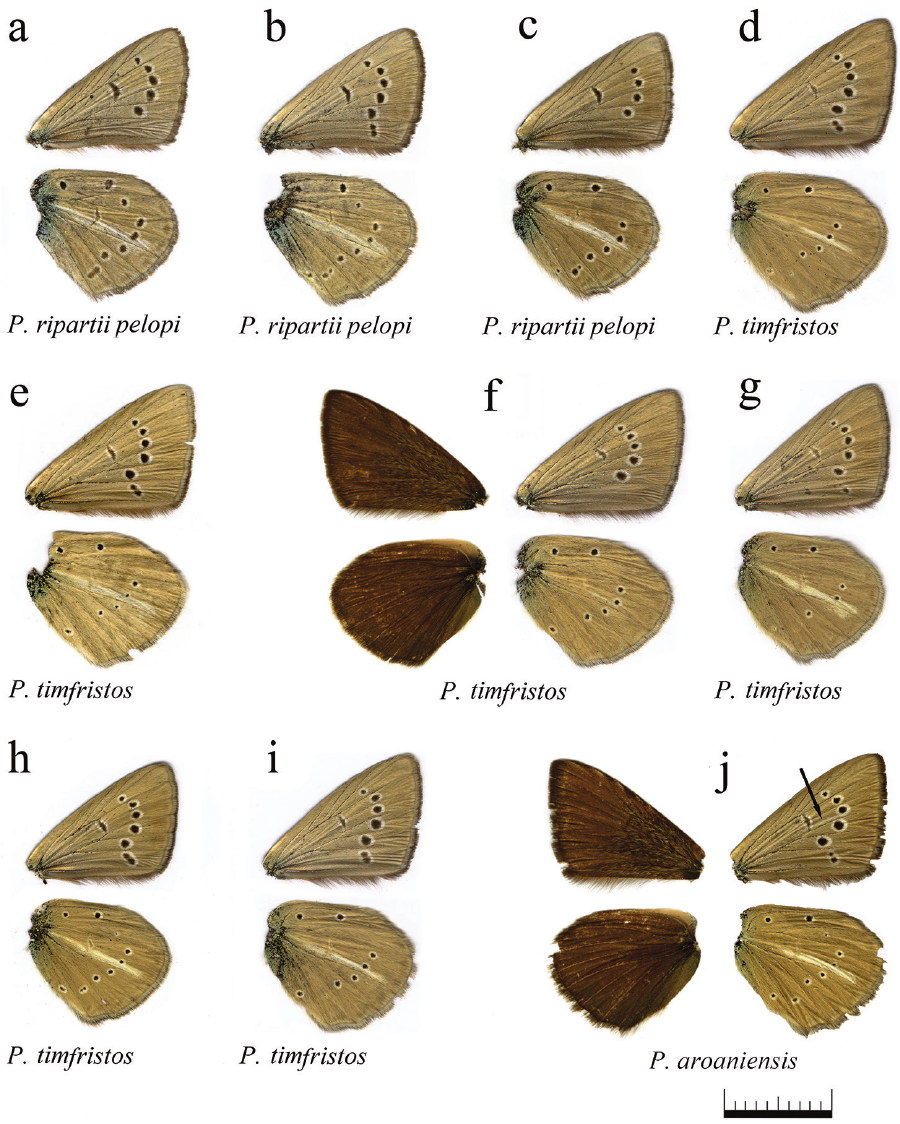
Figure 16. The coloration and wing pattern of P. ripartii pelopi , P. timfristos sp. n. and P. aroaniensis . The letters correspond to the following sample numbers: a LR-08-D549 b LR-08-551 c LR-08-571 d LR-08- 273 e LR-08-205 f LR-08-274 upperside and underside g LR-08-258 h LR-08-247 (Holotype) i LR-08- 255 j LR-08-102 upperside and underside. White postdiscal streak between discal spot and submarginal marking on the forewing underside is shown by arrow. Bar = 10